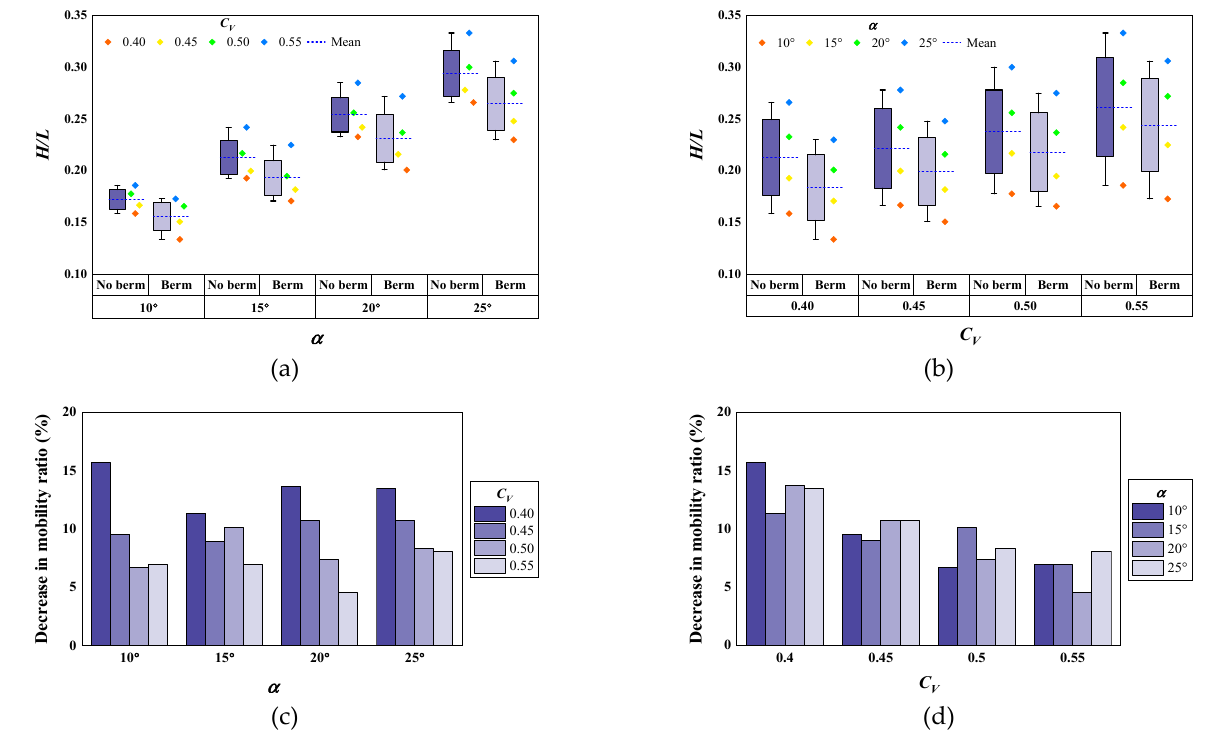
Figure 10. ( a ) Mobility ratio according to α (at C V = 0.40–0.55); ( b ) mobility ratio according to C V (at α = 10°–25°); ( c ) percent decrease in mobility ratio due to berm according to α (at C V = 0.40–0.55); ( d ) percent decrease in mobility ratio due to berm according to C V (at α = 10°–25°).